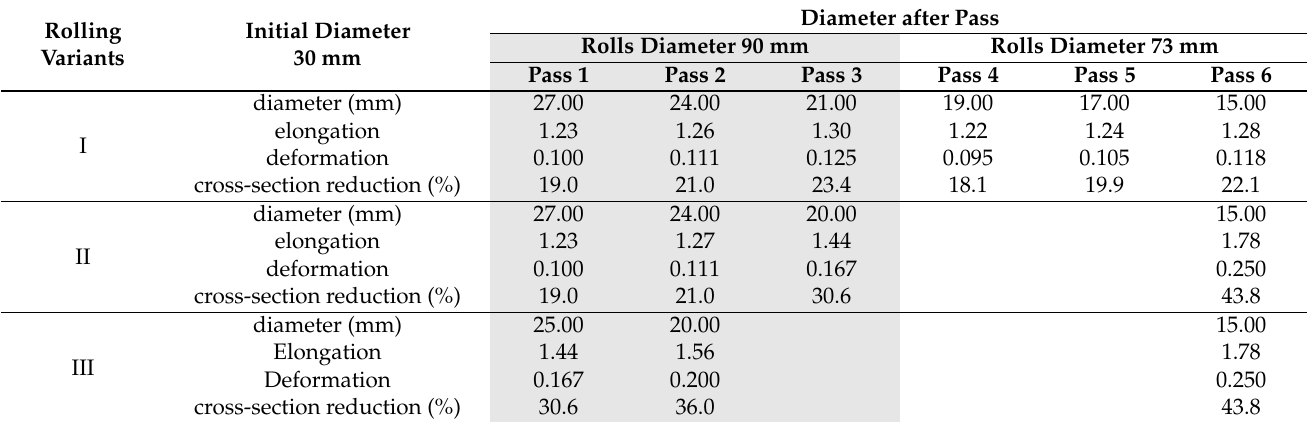
Table 3. The pattern of deformations used in the RSR process for individual variants of rolling.